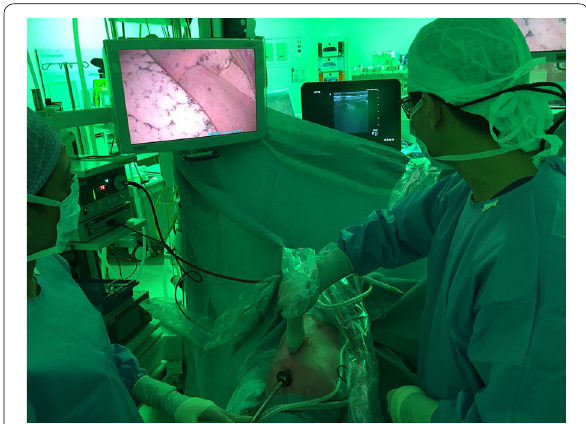
Fig. 2 The surgeon performs lung ultrasonography in a patient with a confirmed pneumothorax and the videoscope in situ. The video screen displays an image of the inside of the right hemi-thorax and the collapsed right lung. The surgeon is handling the wrapped-up ultrasound transducer. The ultrasound device is shown in the back of the image